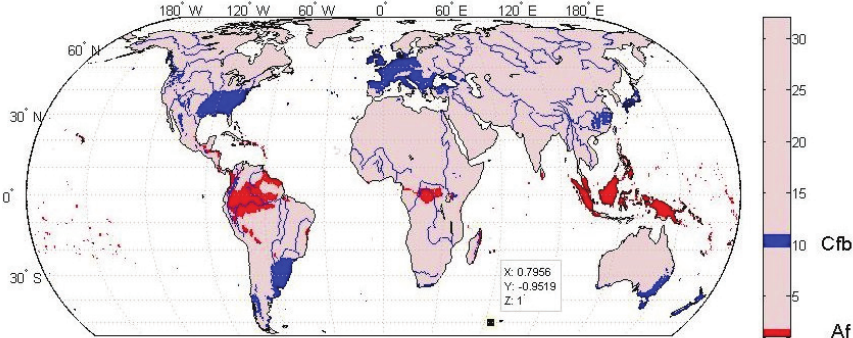
Fig. 4. Selected K¨oppen-Geiger regions used for the NCDA